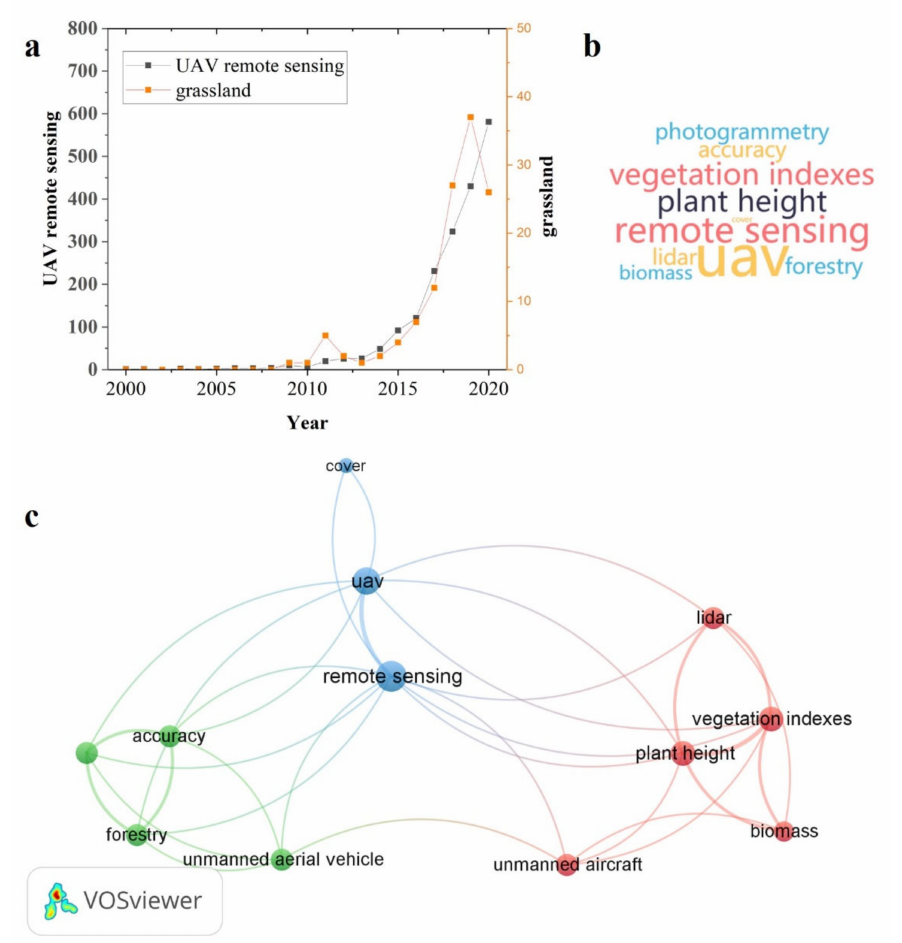
Figure 2. Development trend of unmanned aerial vehicle (UAV) remote sensing and research hotspots in grassland ecosystems. ( a ) WOS philological analysis, ( b ) keyword cloud image and ( c ) keyword co-occurrence analysis. In ( c ), the same color indicates that keywords are closer and may appear together in several papers. The larger the node is, the more frequently the keyword